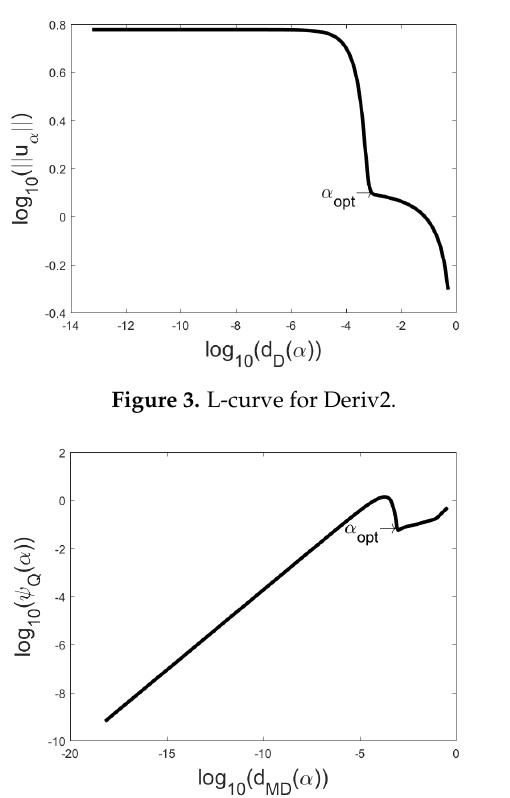
Figure 4. Q-curve for Deriv2.